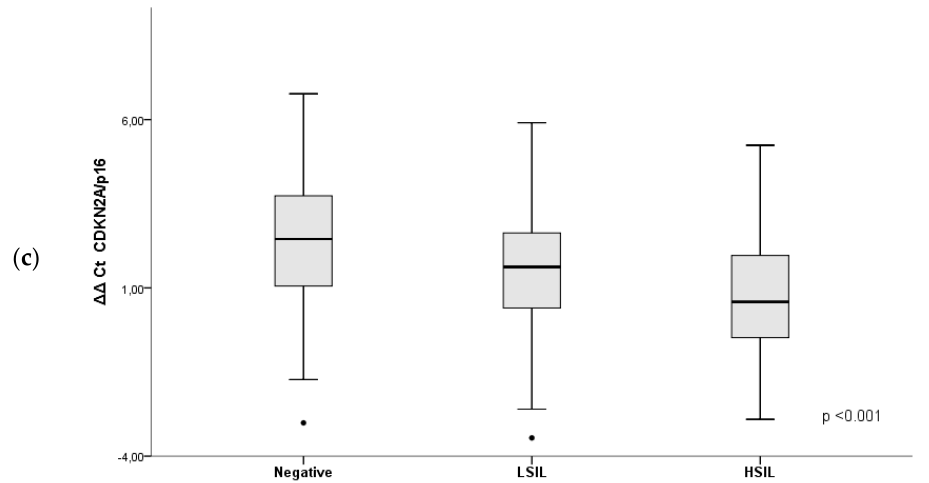
Figure 1. Boxplots showing the mRNA levels of ( a ) TOP2A; ( b ) MKI67; ( c ) CDKN2A / p16 in the di ff erent diagnostic groups. Patients were grouped into three categories according to the cytological, histological, and virological results. These categories included: (a) Negative (negative Pap test result and negative high-risk human papillomavirus [HPV] test); (b) low-grade squamous intraepithelial lesion (LSIL) (Pap test result of LSIL and biopsy showing anal intraepithelial neoplasia grade 1 [LSIL / AIN1]); and (c) high-grade squamous intraepithelial lesion (HSIL) (patients with Pap test result of HSIL and biopsy confirming HSIL / AIN2–3). The values shown are expressed as ∆∆ Ct [(cycle threshold target-cycle threshold reference sample) − (cycle threshold SiHa-cycle threshold reference SiHa)]. The black line within the box represents the median; the whiskers represent the minimum and maximum values that lie within 1.5 interquartile ranges from the end of the box. Values outside this range are represented by black dots. Table 2. mRNA levels of TOP2A, MKI67 and CDKN2A/p16 according to the diagnostic group. Diagnosis